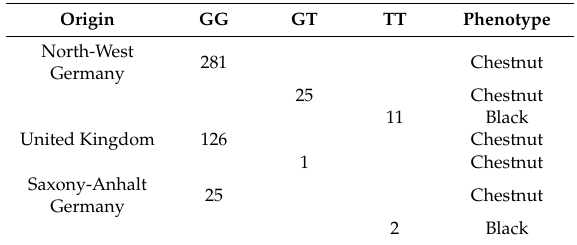
Table 3. Results of blind test of SNP c.33G > T in 471 European roe deer (details in Table S1).